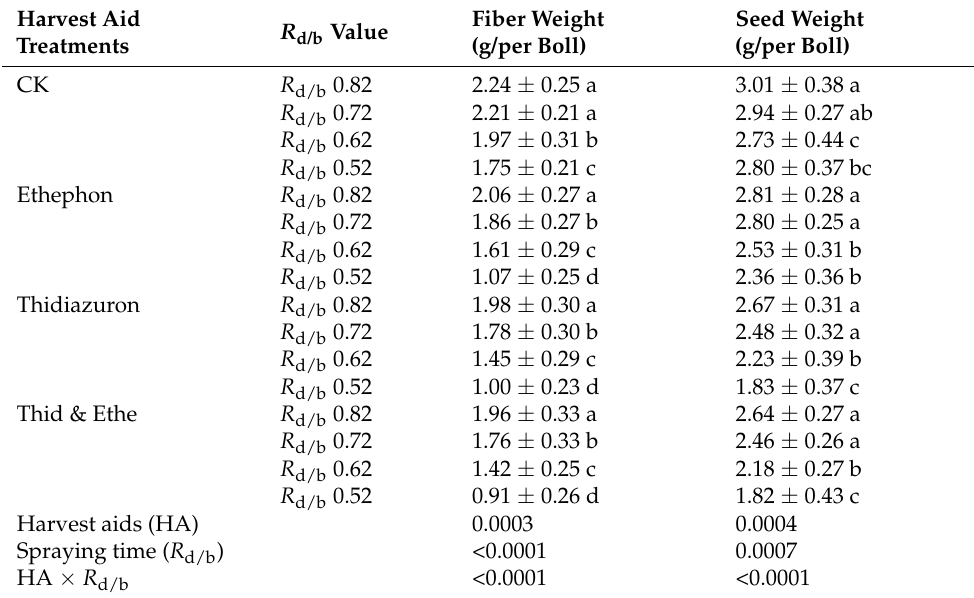
Table 3. Variance analysis of single boll components under different harvest